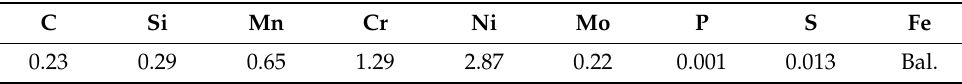
Table 1. Chemical composition of the tested steel (wt.